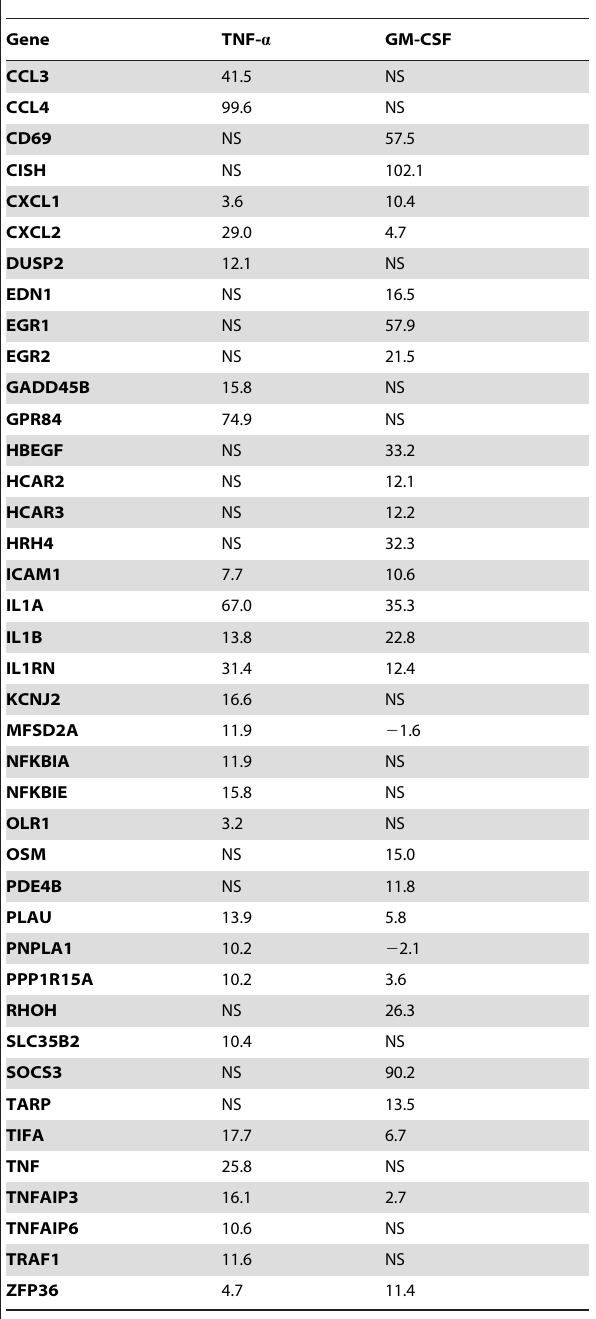
Table shows fold change in gene expression (RPKM) compared to level expressed in untreated neutrophils. Change in gene expression is significant with a 5% FDR (NS=not significant). doi:10.1371/journal.pone.0058598.t001 mouse IgG (Sigma) HRP-linked antibodies (1:10,000). Bound antibodies were detected using the ECL system (Millipore) on carefully exposed film (Amersham) to avoid saturation.